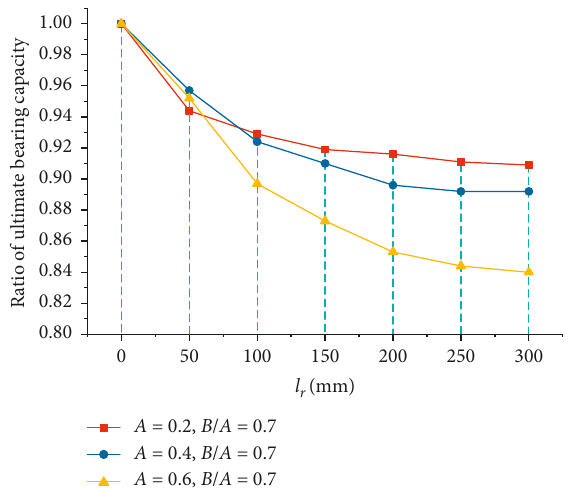
Figure 17: Comparison of the ultimate bearing capacity versus l